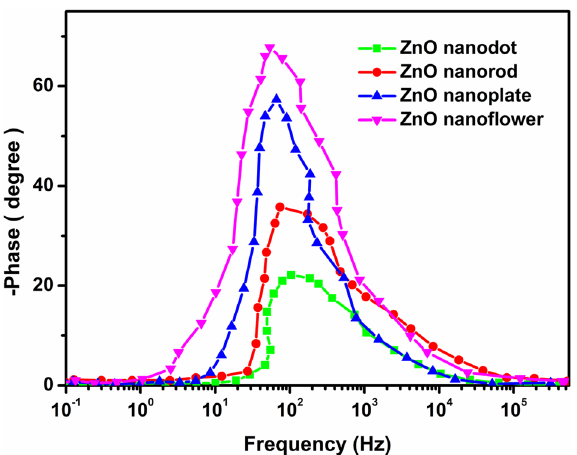
Figure 12. Bode-phase plots of fabricated DSSCs with ZnO nanostructures as